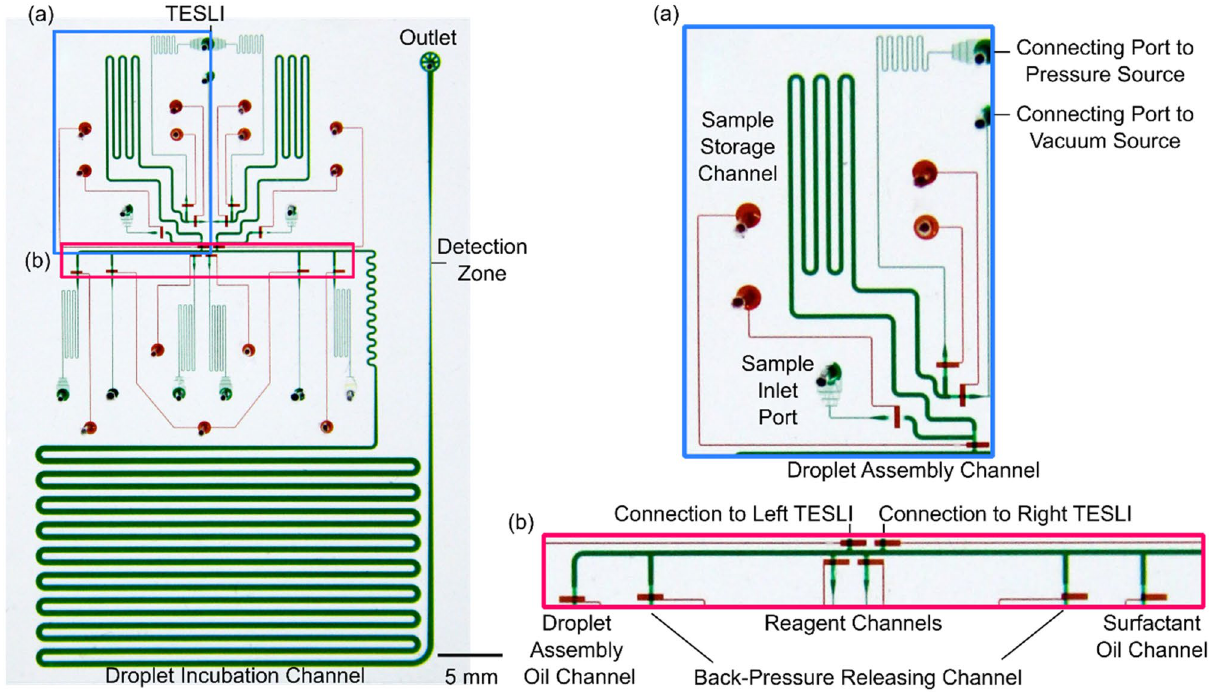
Figure 2. Integrated droplet device with dual TESLIs. The integrated droplet device is composed of two PDMS layers: the top fluidics layer where droplets are generated, incubated, and detected (filled with green dye for visualization) and the bottom valve layer where microvalves are actuated to regulate droplet generation and flow (filled with red dye for visualization). ( a ) Each TESLI is composed of an open-to-atmosphere sample inlet port for directly spotting samples, a sample storage channel for storing the infused samples, a connecting port to an external vacuum source for infusing samples, a connecting port to an external pressure source for injecting infused samples into droplets, and four corresponding microvalves for controlling the fluid flow. ( b ) Droplet assembly is conducted in the 200-µm wide droplet assembly channel, to which the inlet nozzles from dual TESLIs and the inlet nozzles of two reagent channels are connected. Upstream from droplet assembly channel is the droplet assembly oil inlet for introducing the oil phase that facilitates droplet assembly and propels generated droplets downstream. Two back-pressure releasing channels that flank the droplet assembly channel can open to atmosphere, alleviate build-up of back-pressure, and ensure volume uniformity of assembled droplets.